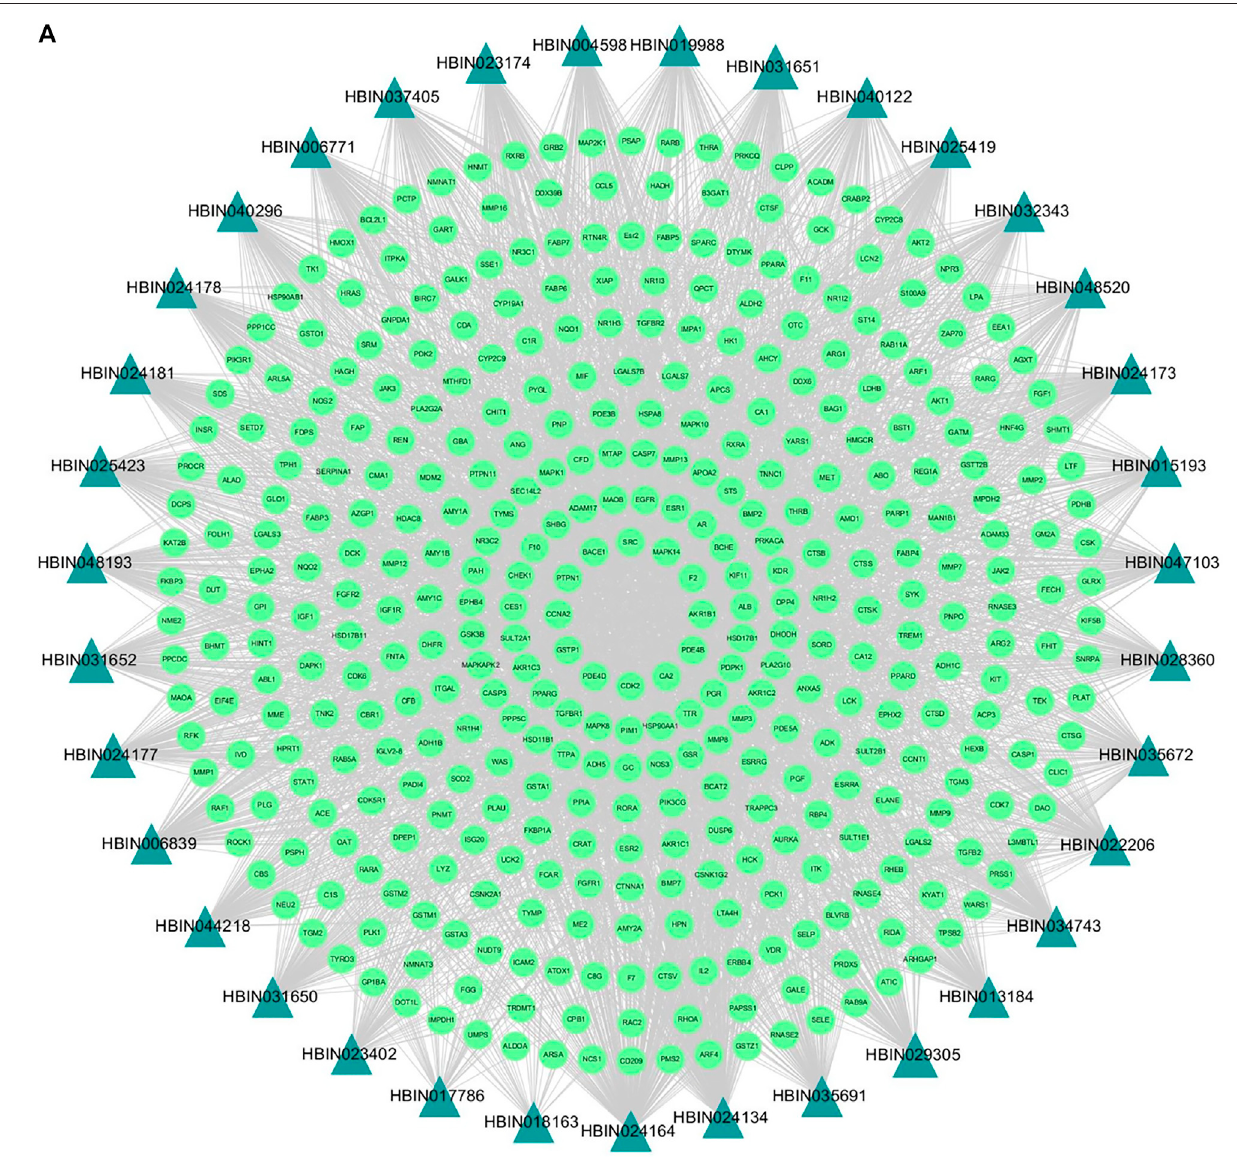
FIGURE3| Compound-targetnetworkandprotein-proteinInteraction(PPI)networkofGDtargets. (A) Thecompound-targetnetworkofDNR.Activecompounds were represented by bottle green triangle nodes, and targets were represented by pale green circular nodes. (B) The PPI network of GD targets. The nodes size and color depth image are proportional to their degree